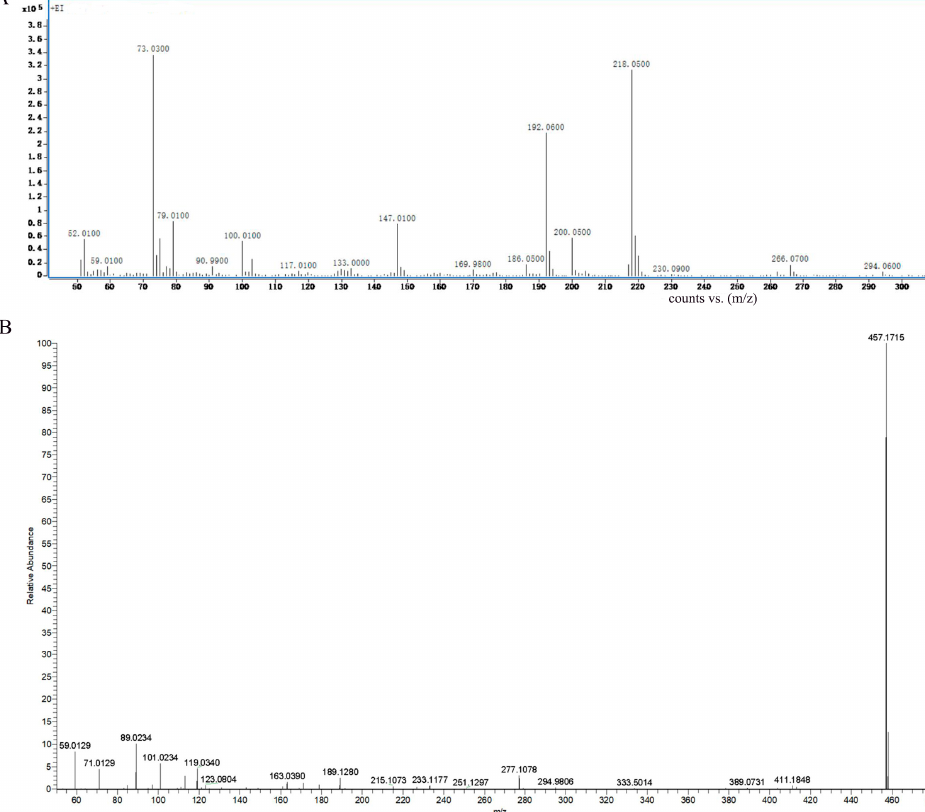
Figure 3. Primary mass spectrum of L -phenylalanine damaged leaves attacked by E. onukii of C. tetracocca ( A ). The secondary mass spectrum of compound epigallocatechin-7-O-gallate damaged leaves attacked by E. onukii of C. tetracocca ( B ).